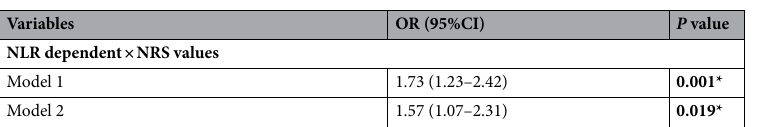
Table 3. Logistic regression between the nutrition risk screening (NRS, 2002) and neutrophil-lymphocytes ratio (NLR) in hospitalised cancer patients. Model 1: no adjusts. Model 2: adjusted by sex, age, physical activity, alcohol intake, smoking status, body mass index, cancer type, treatment type and performance status. * p < 0.05 was considered as